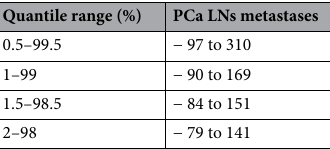
Table 2. Descriptive statistics of HU distribution with different quantile ranges for PCa LNs masks and metastases.